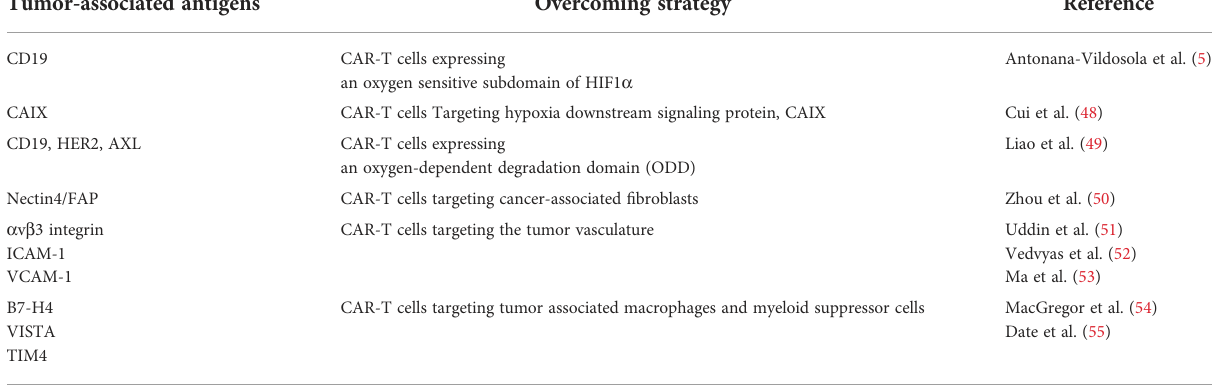
TABLE 1 Safety strategies for overcoming the suppressive tumor microenvironment by CAR-T cells. Tumor-associated